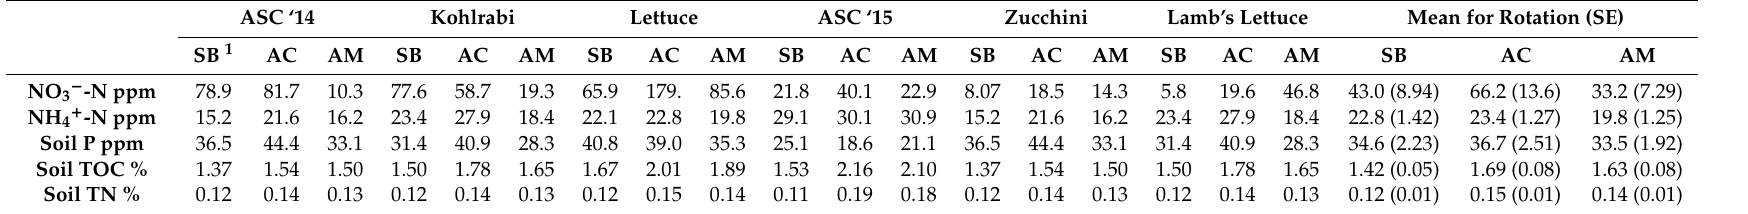
Table 5. Means of soil chemical parameters for the three organic systems during the two-year rotation period.